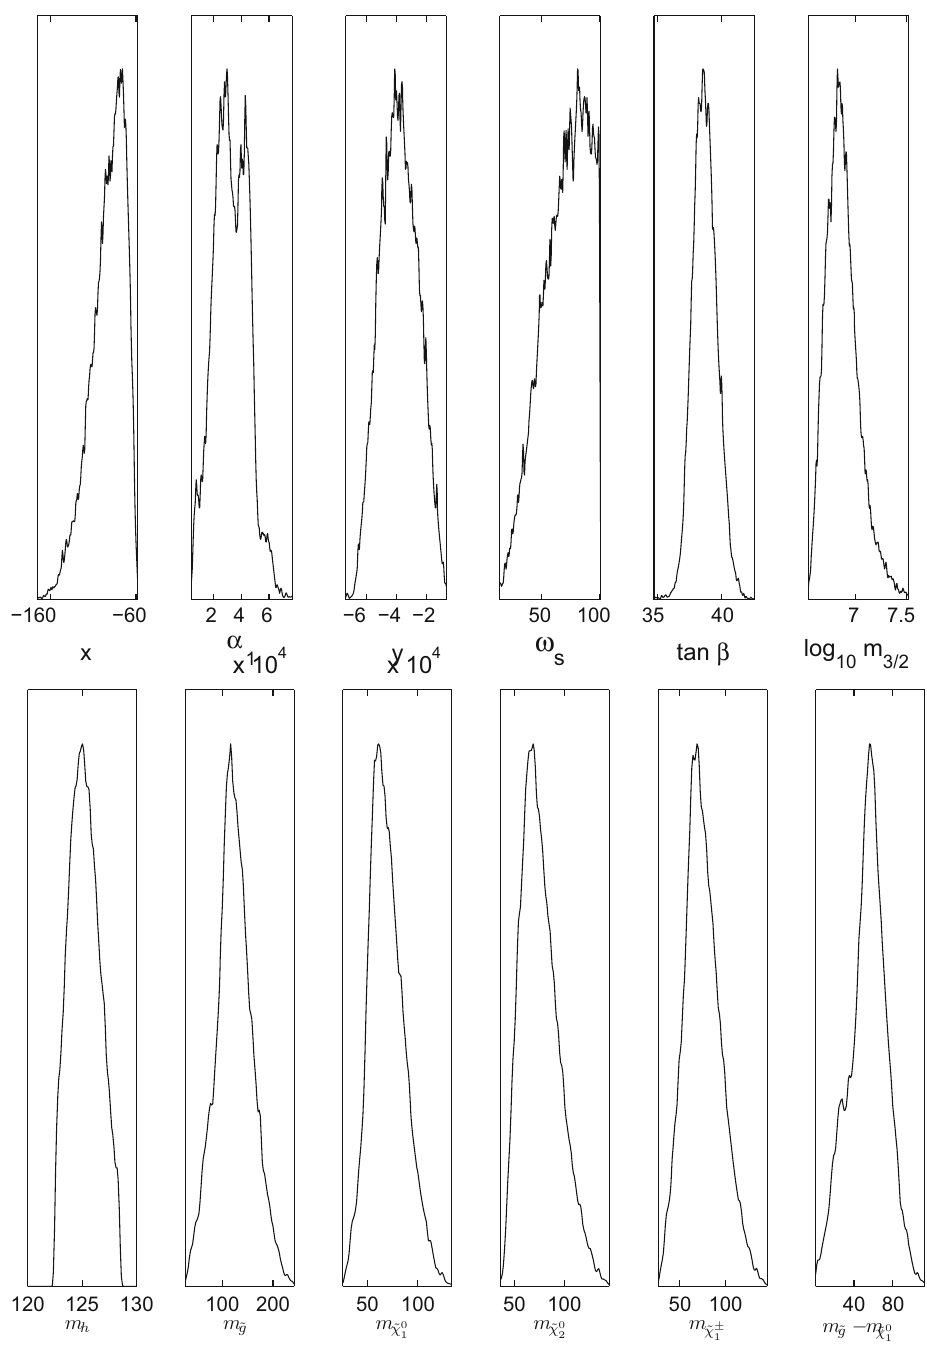
Fig. 1 First row One-dimensional posterior probability distributions fortheSUSY-breakingparametersand( secondrow )fortheHiggsboson and electroweak ino mass in GeV units. Corresponding squark masses